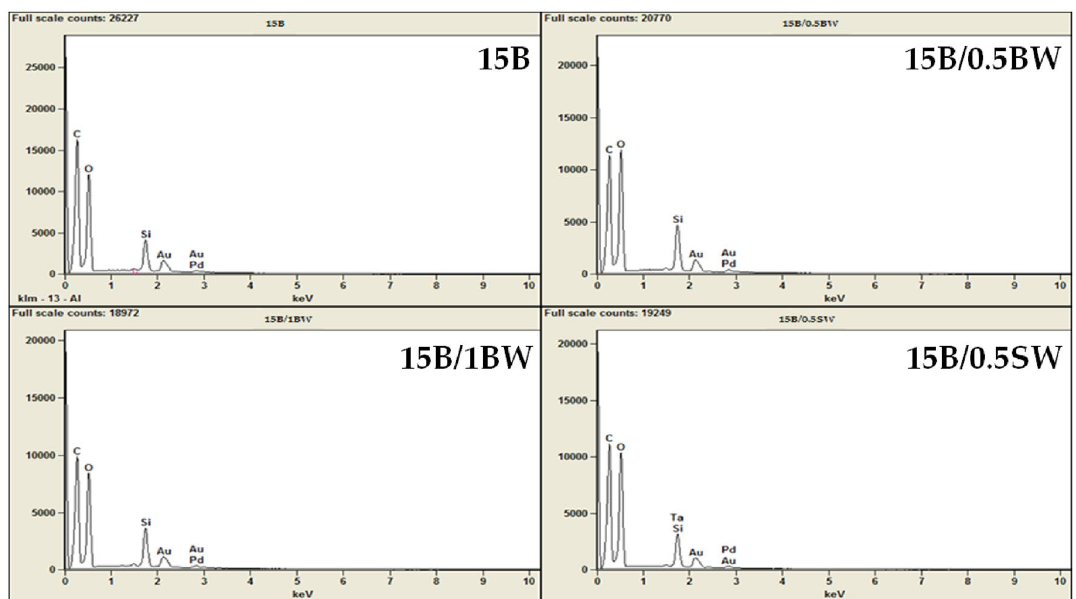
Figure 15. EDS mapping of composite